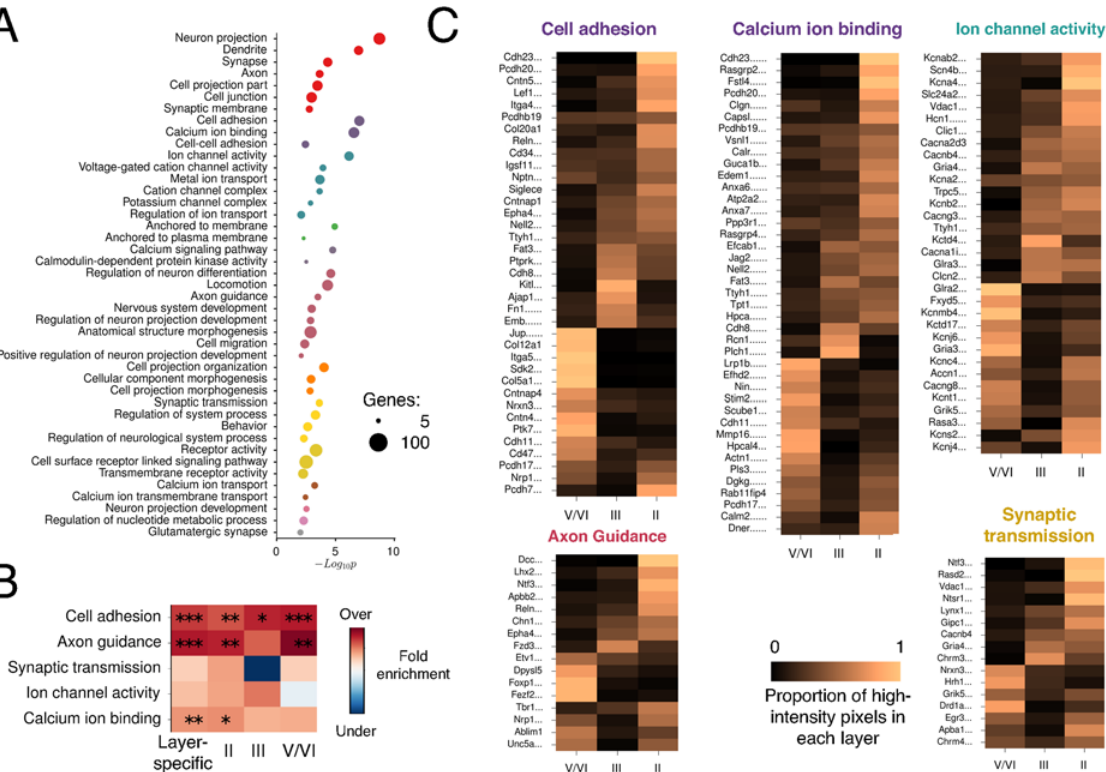
Figure 6. Functionally grouping of genes with laminar organization. (A) Enriched functional clusters of gene ontology (GO) and KEGG pathway terms. Overrepresented annotations were identified using an overrepresentation analysis in GOElite [102]. Colors reflect terms clustered based on kappa similarity [103]. Only the most significant annotations (FDR < 0.01) that are sufficiently different from other terms in cluster (kappa score < 0.7) are shown. (B) Colors indicate the log 2 fold enrichment of the term in the layer-specific list, or lists for individual layers, compared with all MEC-expressed genes. Asterisks indicate significance at * α = 0.05, ** α = 0.01, *** α = 0.001. (C) Colors represent the normalized proportion of high-intensity ( (cid:1) 2 x mINT MEC ) pixels in each layer for genes in each of the indicated overrepresented groups. Data were normalized by dividing the proportion for each layer by the sum across layers.